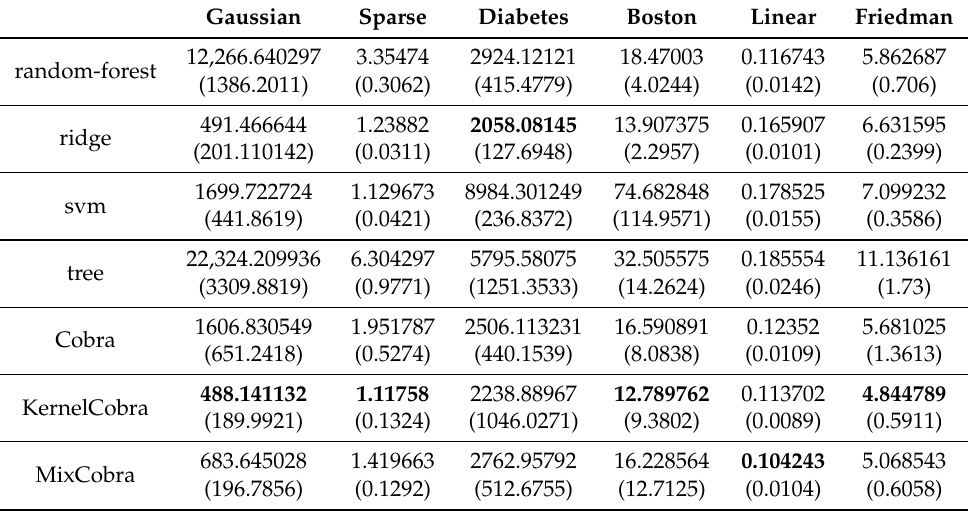
Table 1. For each estimator and each dataset (names point to datasets URLs), we report the mean root mean square error (RMSE—along with standard deviation) over 100 independent runs. Bold numbers indicate the best method for each dataset.